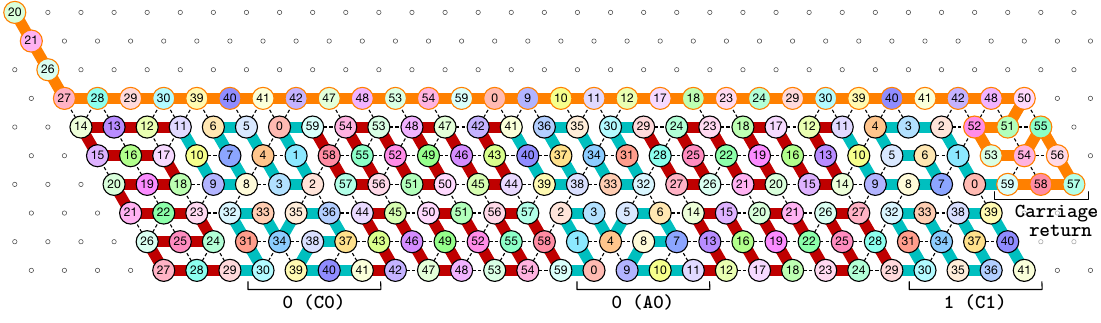
Figure 10. At the end of the first zag pass, the new value of each bit have been encoded into shapes: A0 or C0 for bits equal to 0, A1 or C1 for bit equal to 1.